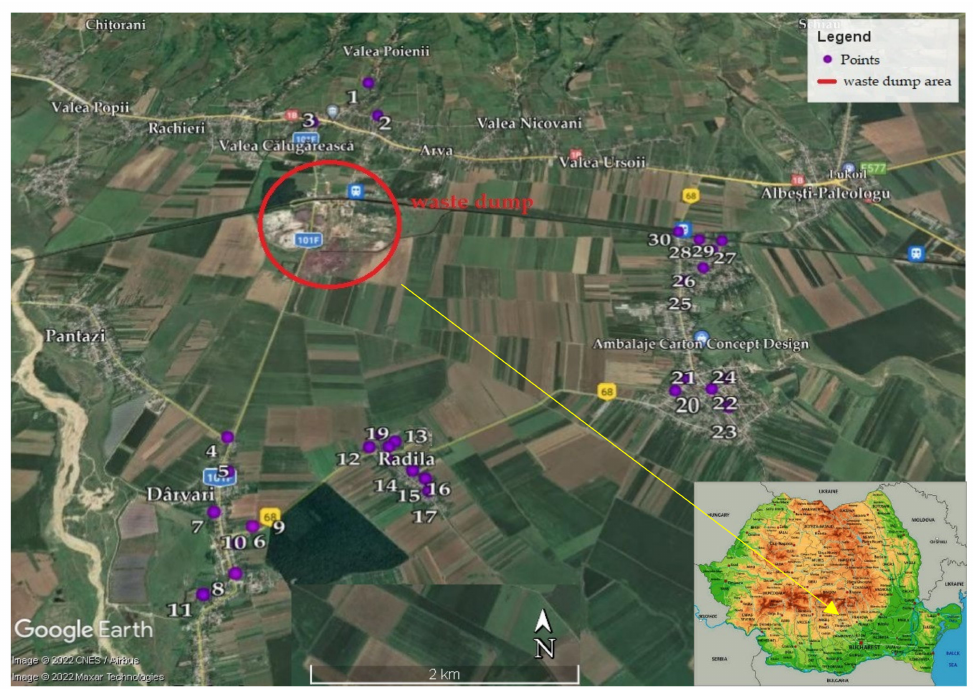
Figure 1. Study area (location map and distribution of sampling points around the sulfury pyrite waste dump). Source: Google Earth